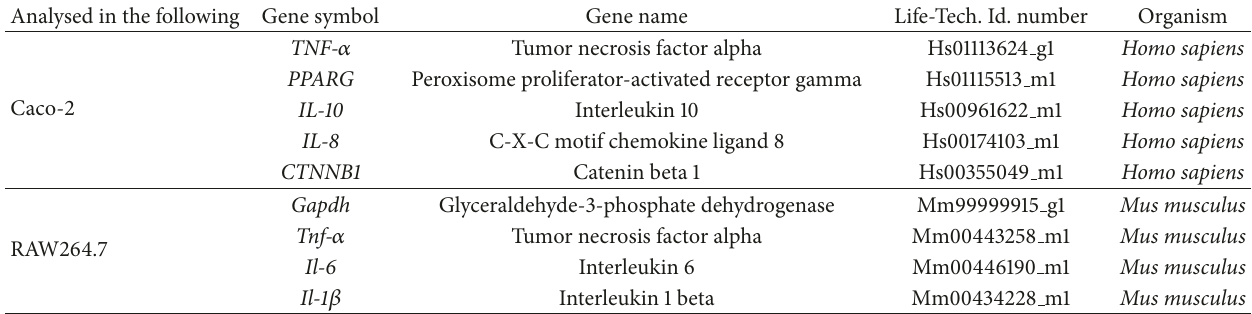
Table 1: Primers used during PCR quantitation of selected genes in Caco-2 and RAW264.7